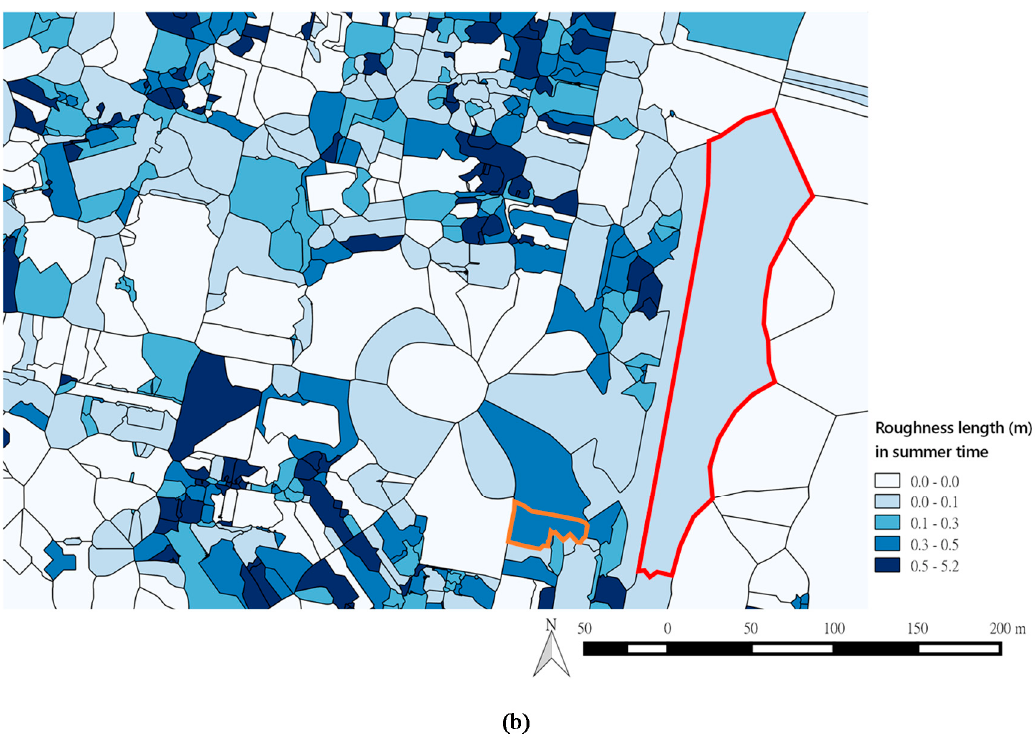
Figure 9. ( a ) The roughness length for incident WD of 0° (winter time); ( b ) The roughness length for incident WD of 270° (summer time).